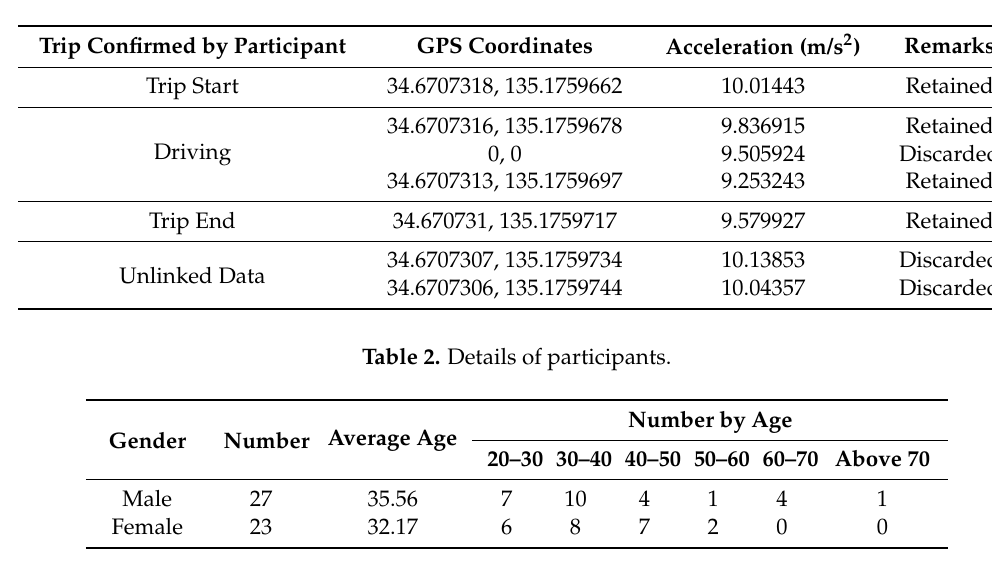
Figure 1. Demographics of Kobe city. Table 1. Example of retained and discarded data.